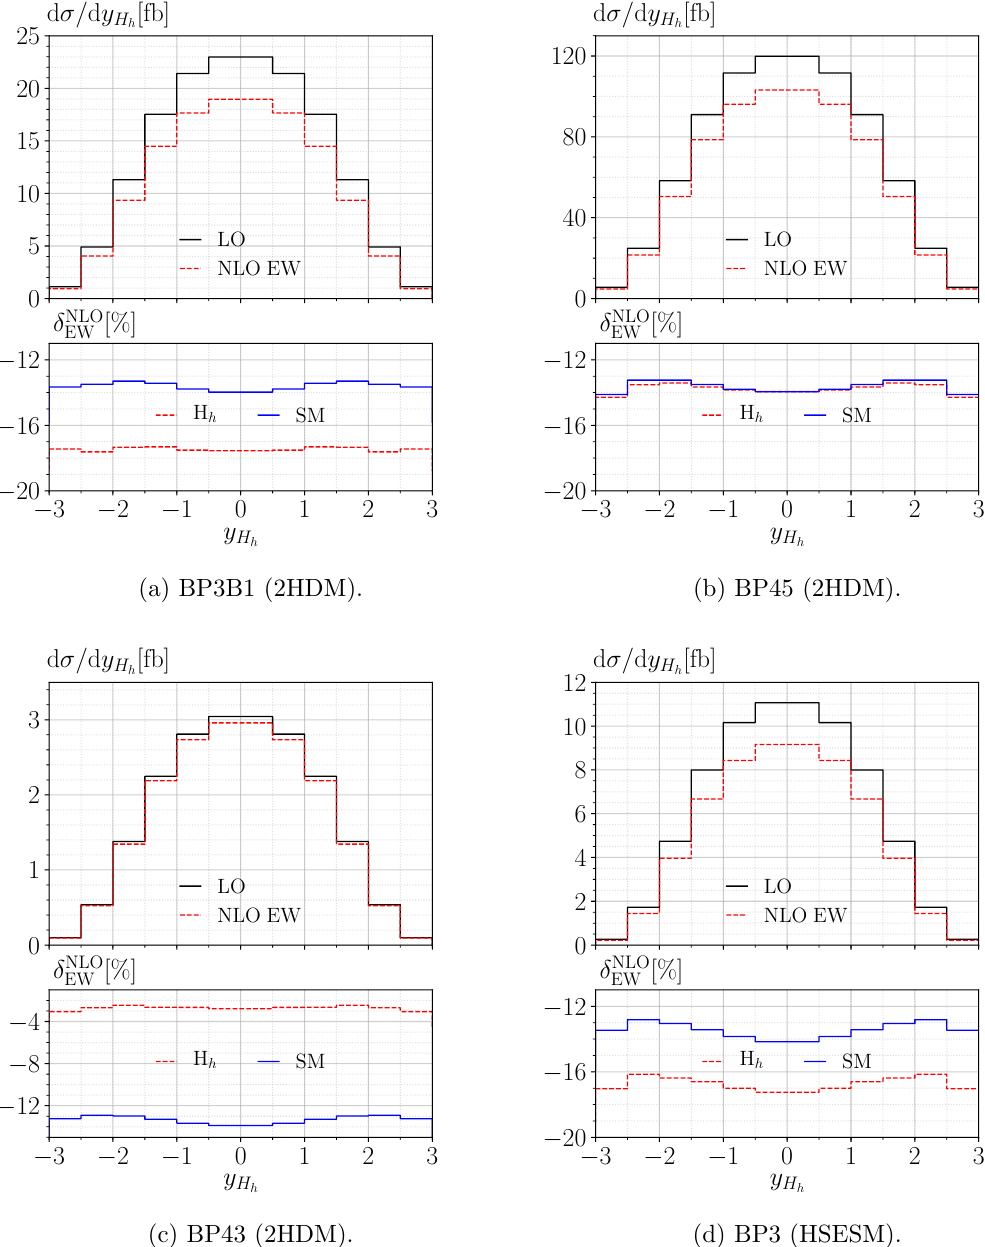
H h for heavy Higgs production in Higgs